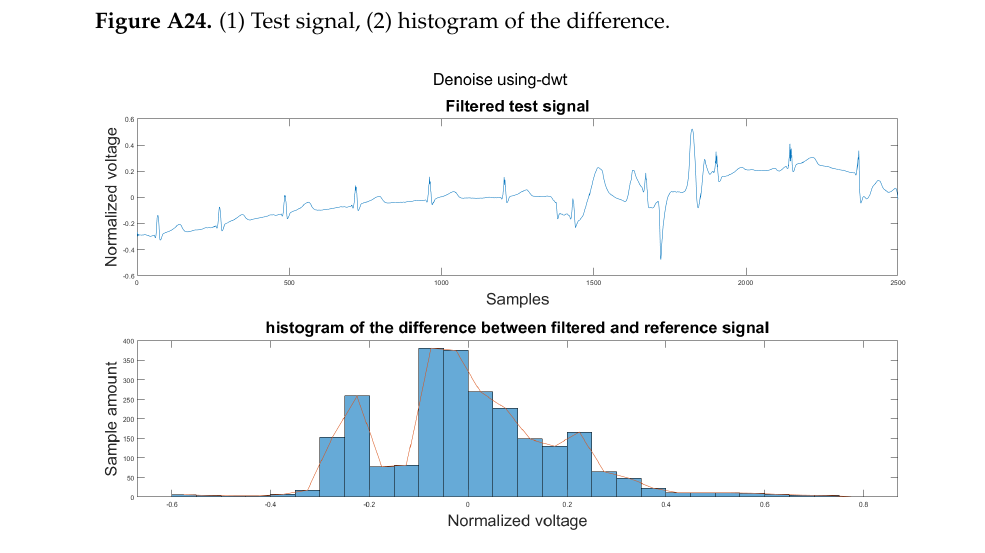
Figure A25. (1) Test signal, (2) histogram of the difference.